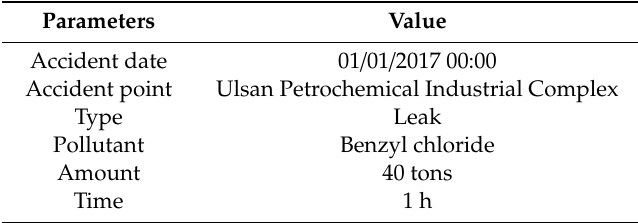
Table 1. Chemical accident scenario